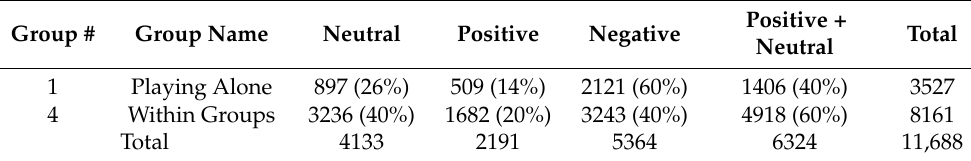
Table 5. Sentiment analysis classification for the preferred gaming style.